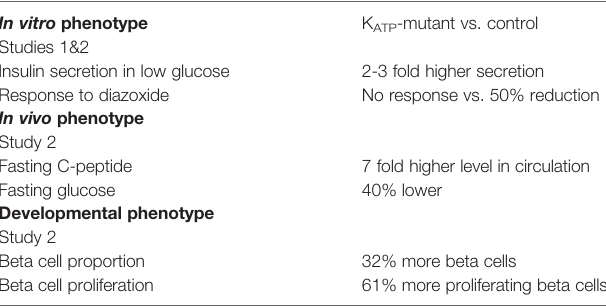
K ATP -mutant vs.